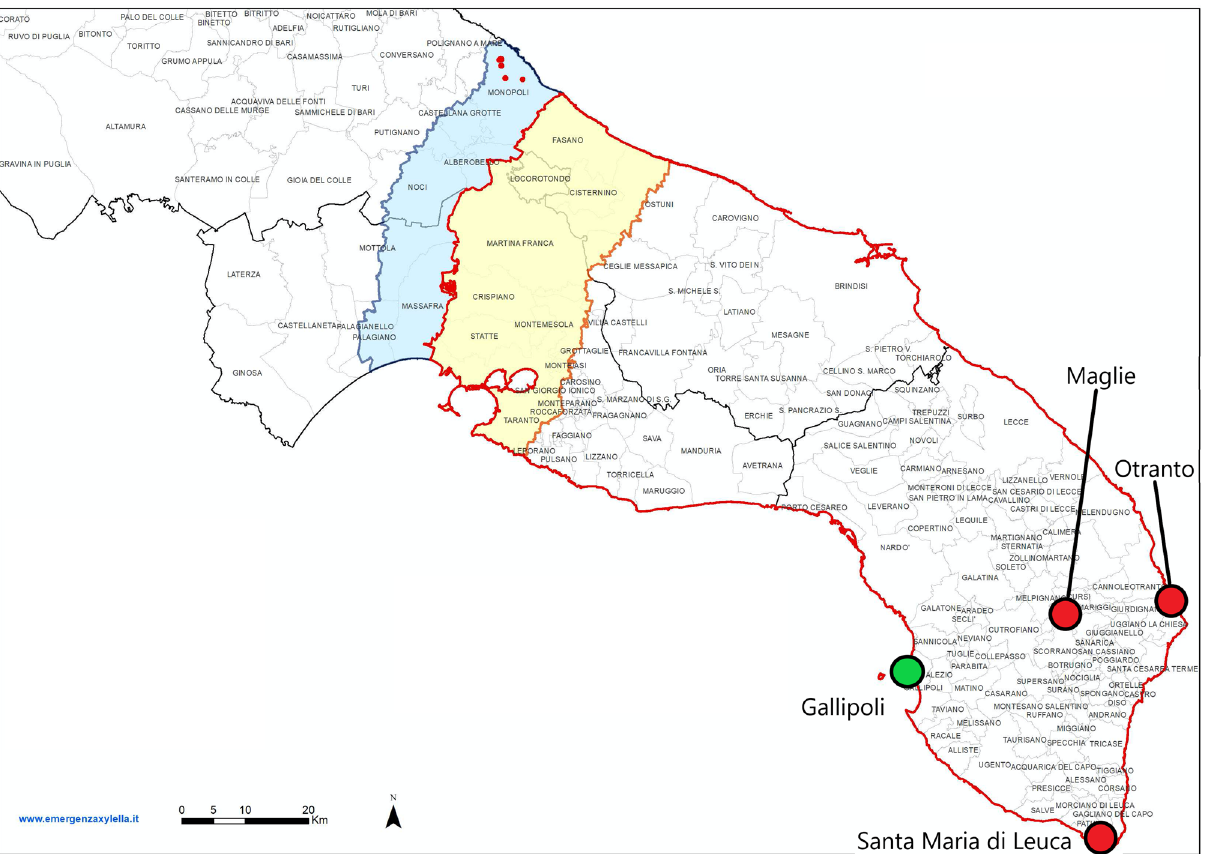
Figure 1. Demarcated areas in October 2020 in the Puglia region, southern Italy. The red outlined region is the whole infected zone. Within the infected zone, the yellow region is the containment zone, where all infected plants must be removed, and all host plants within a 100 m radius of the infected plants are tested. The blue region is the buffer zone, where every infected plant found should be removed, as well as all host plants within a 100 m radius of the infected plant. The red dots in the blue region are newly found infected plants in the buffer zone for which the demarcated zones have not been updated yet. The green dot is the town of Gallipoli, the presumed origin of the outbreak of X. fastidiosa in Puglia. The red dots are the towns of Maglie, Otranto, and Santa Maria di Leuca. These locations are used as alternative origins of the outbreak in sensitivity analyses on the point of origin. The image was obtained from https ://www.emerg enzax ylell